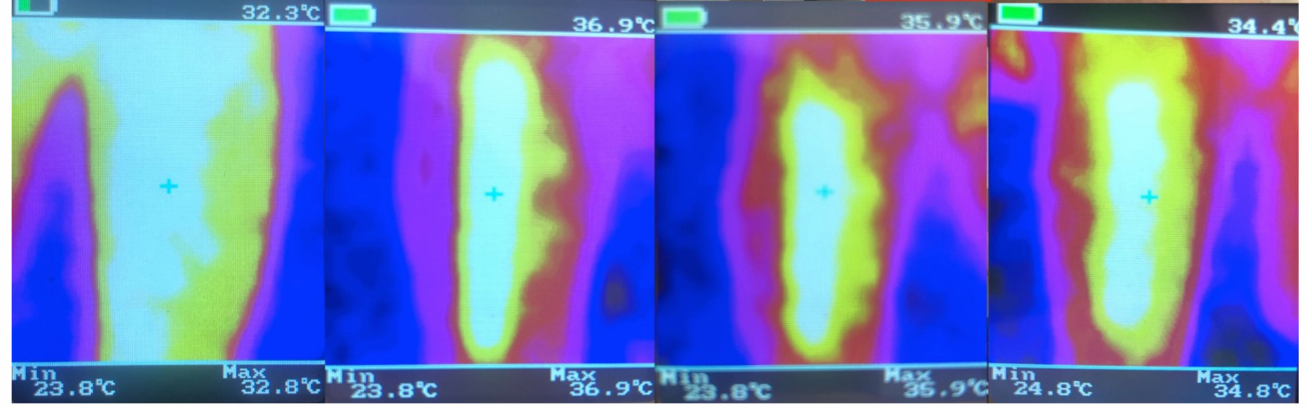
Figure 4. Results of measurements with a thermovision camera (own